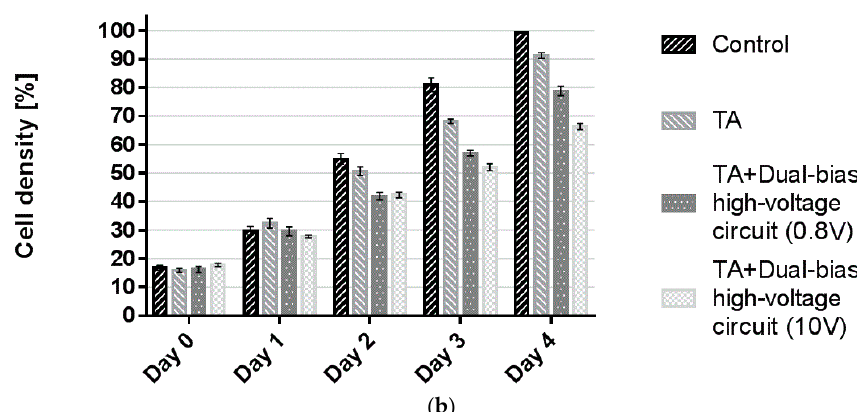
Figure 8. ( a ) Experimental setup of transmit amplifier only and transmit amplifier with dual-bias high-voltage circuit when 0.8 V and 10 V DC voltages were applied to the dual-bias high-voltage circuit. ( b ) Cell densities when using control group, TA (transmit amplifier) only, TA with dual-bias high-voltage circuit with 0.8 V DC, and TA with dual-bias high-voltage circuit with 10 V DC. * p < 0.05.